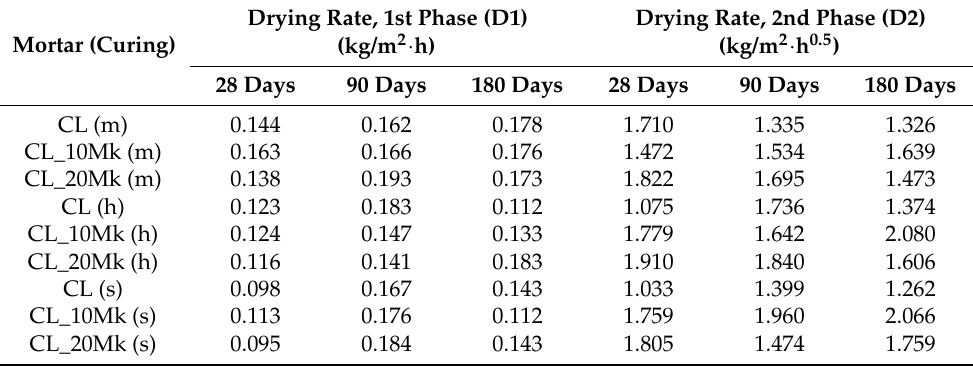
Table 6. Values of drying rates for the first (D1) and second (D2) drying phases of mortars with 0, 10 and 20% Mk replacing air lime, after 28, 90 and 180 days in maritime, humid and standard curing